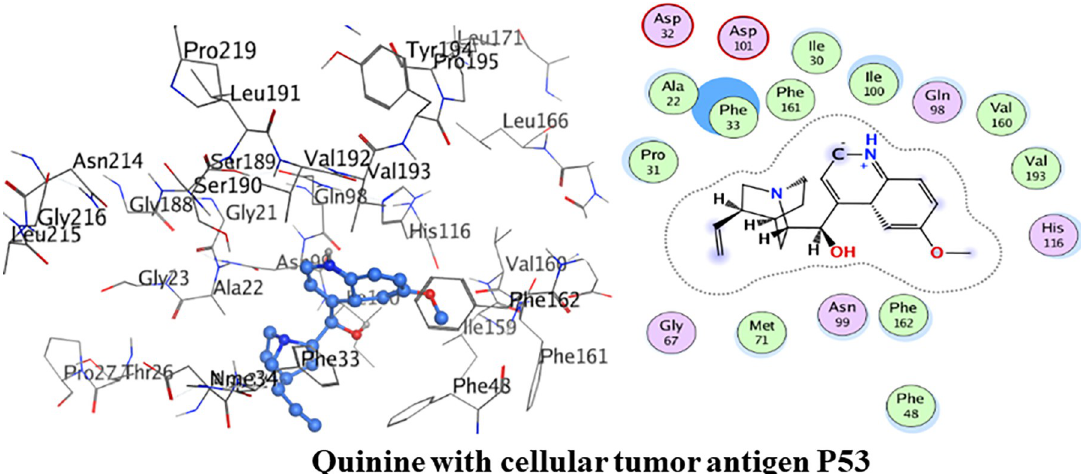
Fig 13. 3D and 2D interactions of quinine with active site of cellular tumor antigen P53.